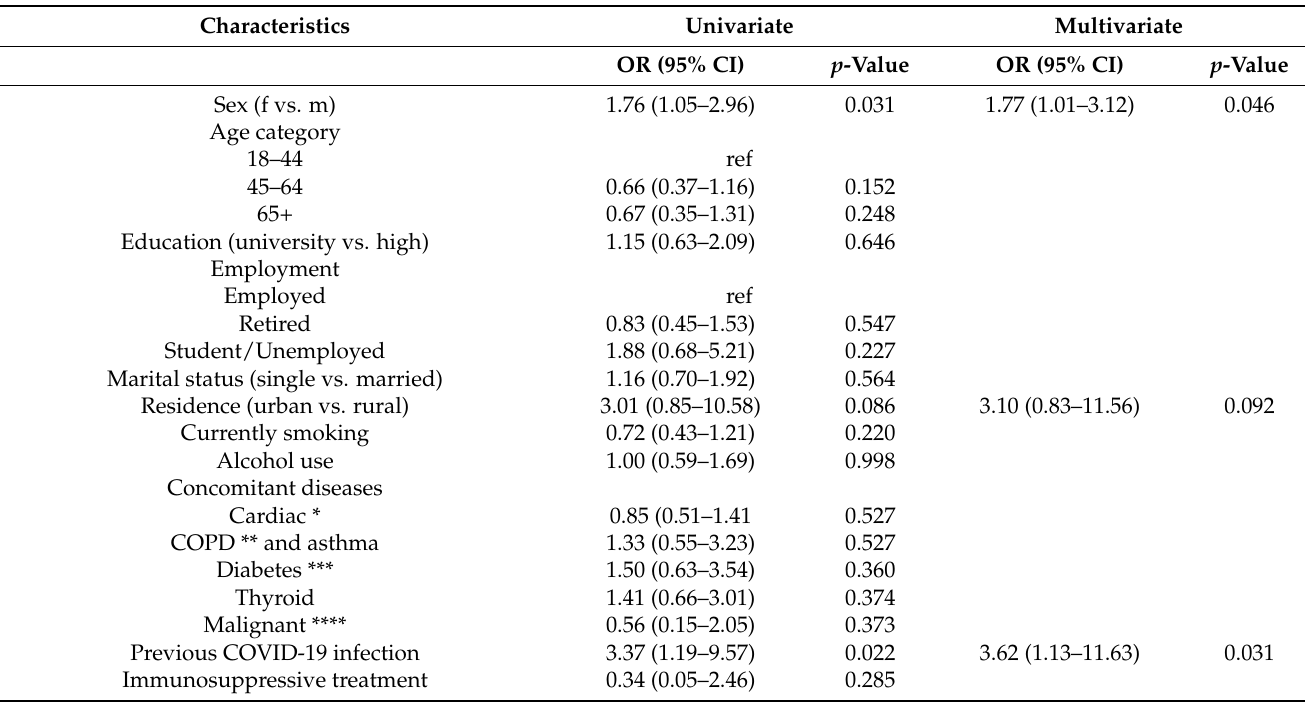
Table 6. Univariate and multivariate analysis of systemic adverse events 7 days after the booster dose of COVID-19